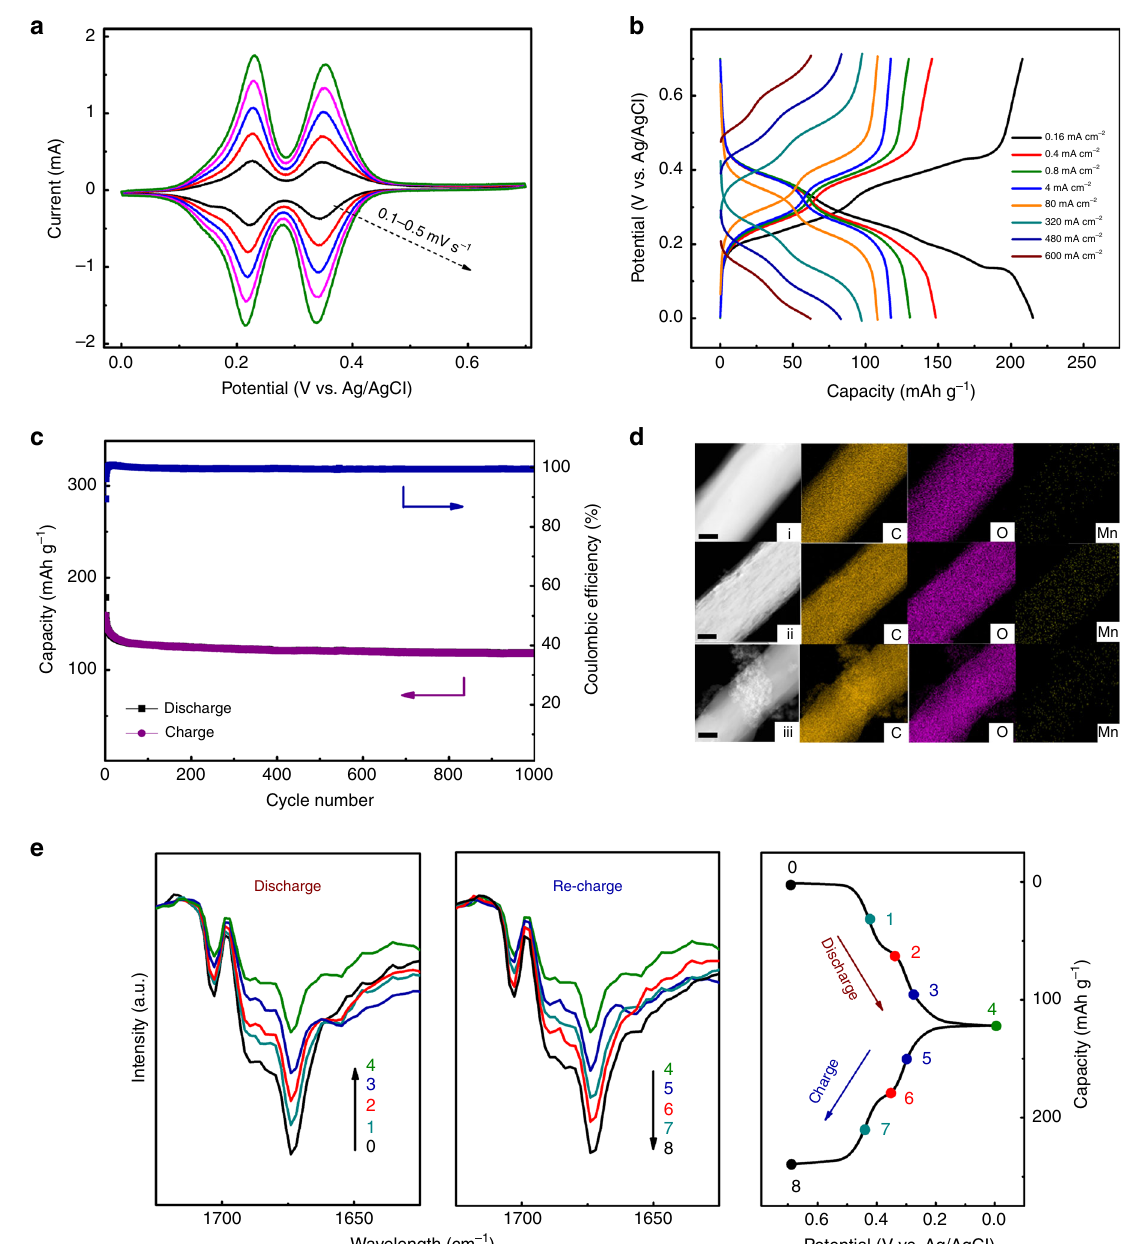
Fig. 2 Demonstrations of the H 3 O + release/capture mechanism on PTO-electrode. a Cyclic voltammetry (CV) curves of PTO-electrode at various scan rates from 0.1 to 0.5 mV s − 1 . b Galvanostatic discharge-charge pro fi les of PTO-electrode at different current densities. c Cycle performance of PTO- electrode at a current density of 2 mA cm − 2 . d TEM-HADDF and STEM EDS-elemental mapping images of PTO-electrodes at (i) pristine, (ii) fully-reduced, and (iii) recovered states. Scale bar: 100 nm. e Ex-situ FT-IR spectra of PTO-electrode at various discharged/charged states during a galvanostatic cycle (as marked points on the right discharge-charge curves). All the electrochemical tests for characterization were conducted at a current density of 2 mA cm − 2 (2.5 C) in a three-electrode system. 2 M MnSO 4 + 2 M H 2 SO 4 solution were used as